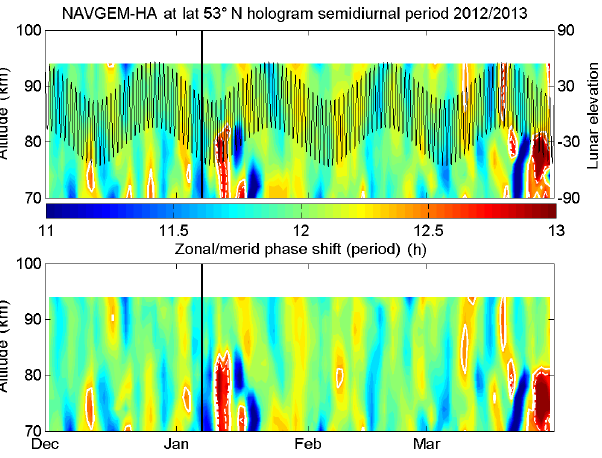
Figure 13. The same as Fig. 12 but for the global tidal analysis of the